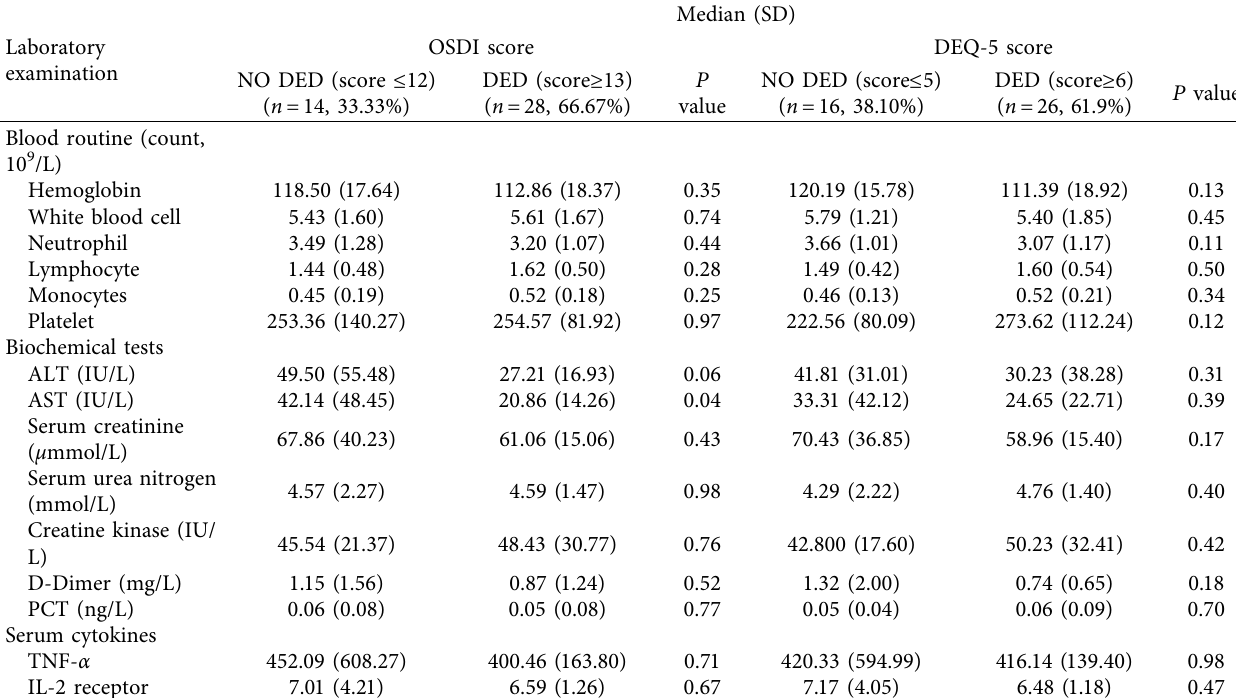
Table 2: The laboratory findings of COVID-19 patients with DED